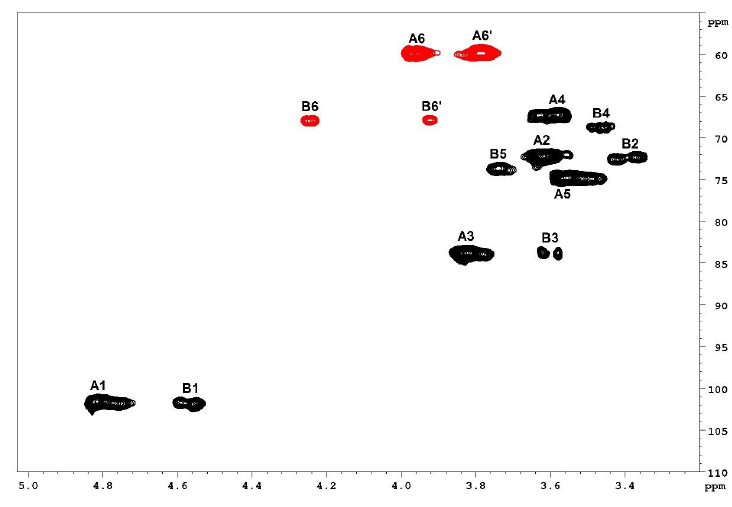
Figure 7. 2D-NMR (HSQCed) spectrum of the LM. Letters refer to spin systems and numbers refer to the positions of spin systems. Table 3. Chemical shift assignments of the NMR spectra of LM from L. variegata .